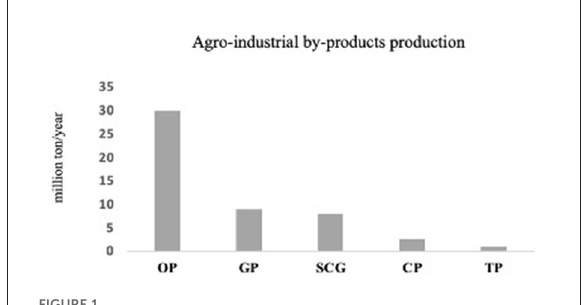
FIGURE1 Agro-industrial by-product annual production (Year 2017).